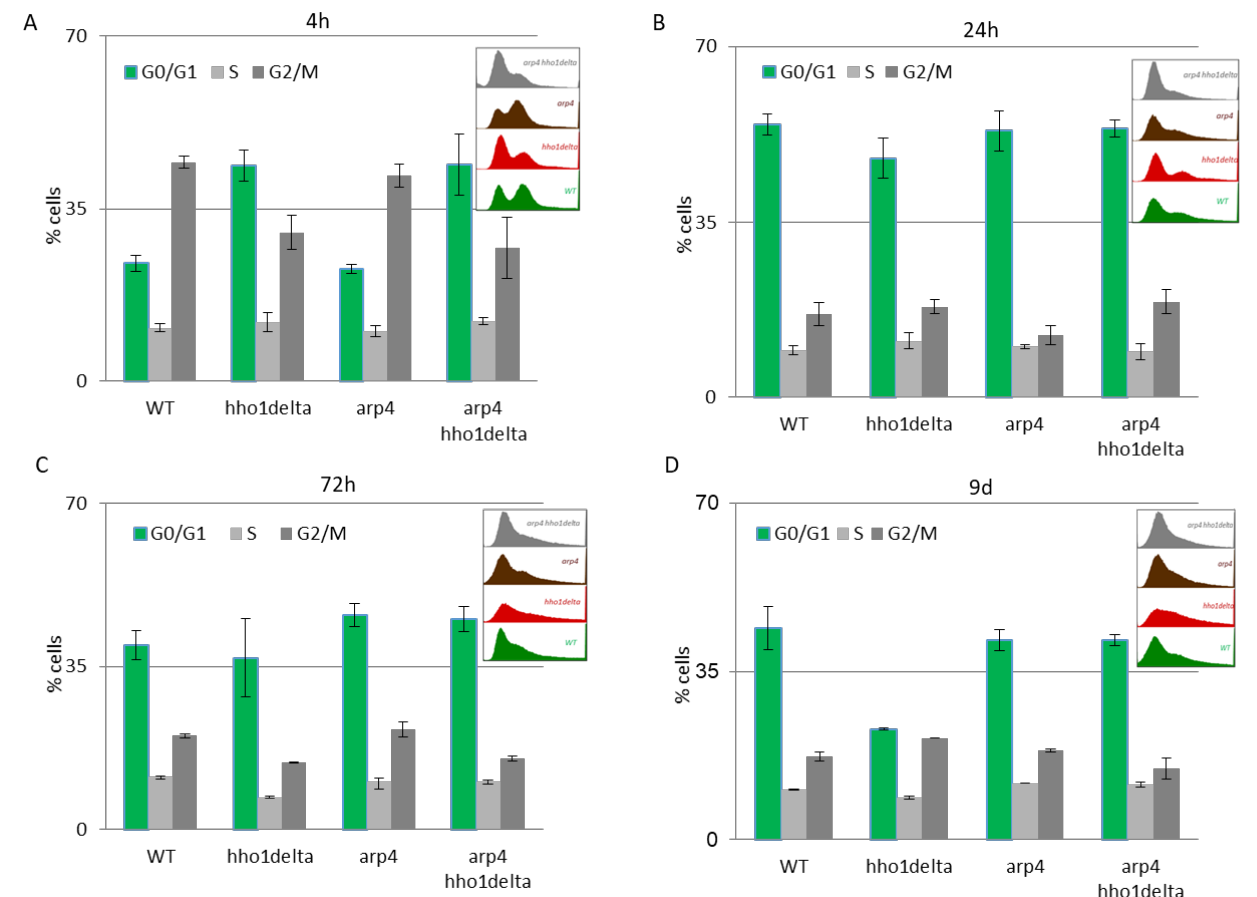
Figure 4. FACS data for studying the cell cycle progression of WT, hho1delta , arp4, and arp4 hho1delta yeast cells cultured for a period of nine days under optimal CLS conditions. Three repetitions of the experiment are done and results are presented as MEAN ± STDV. ( A ) FACS data of logarithmically growing cells with embedded representative histograms. ( B ) FACS data of 24-hour yeast cell cultures with embedded representative FACS cell cycle data histograms. ( C ) FACS data of 72-hour yeast cell cultures with representative FACS cell cycle data histograms. ( D ) FACS data of 9-day yeast cell cultures with representative FACS cell cycle data histograms.